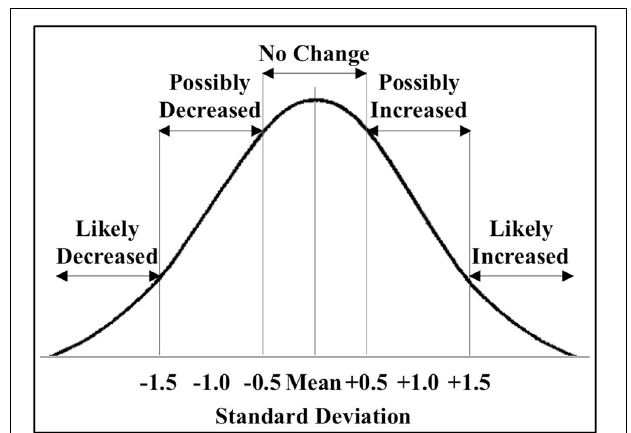
FIGURE 2 | Classification of miRNAs altered by ischemia. The figure shows the distribution of the miRNAs altered by ischemia relative to control in male and female mouse cortex. For initial studies we focused on miRNAs that were significantly decreased ( < − 1.5 SD ) or increased ( > 1.5 SD ) in the male and female mouse